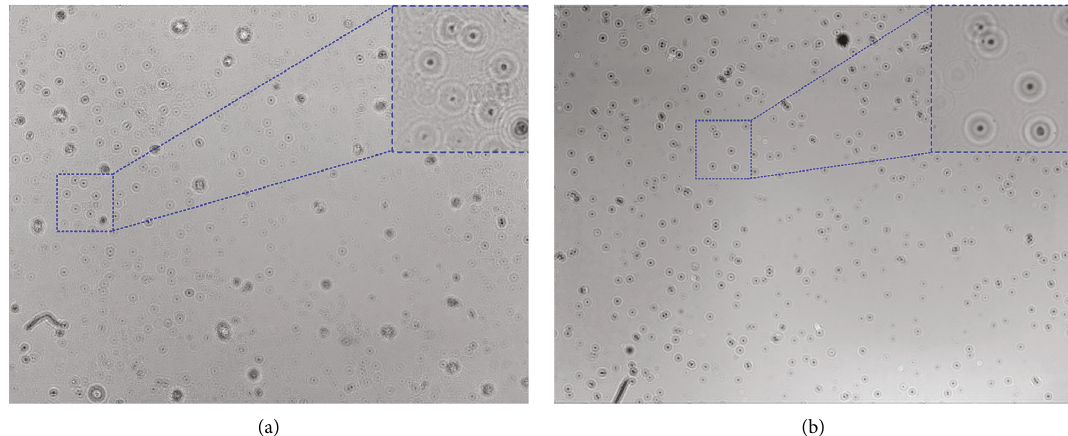
Figure 2: Resolution evaluation of the imaging system: (a) raw hologram data obtained in size 3280 target region of interest; (c) reconstructed hologram; (d) normalized intensity profile of group 7 element 6.